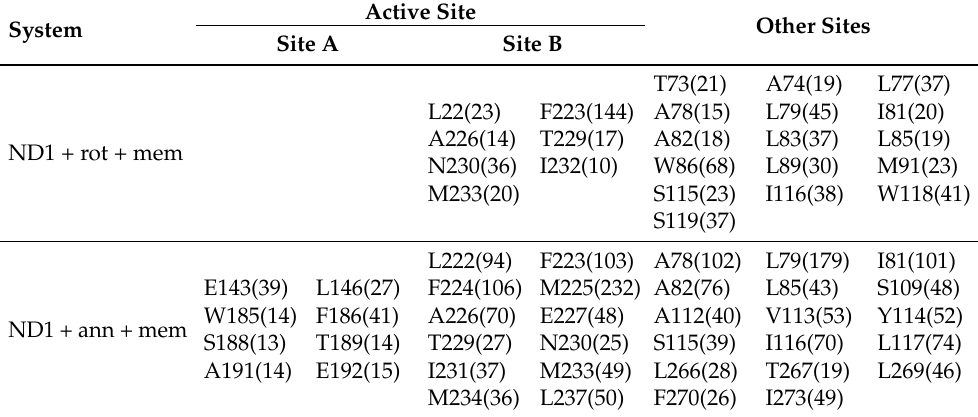
Table 4. Contact